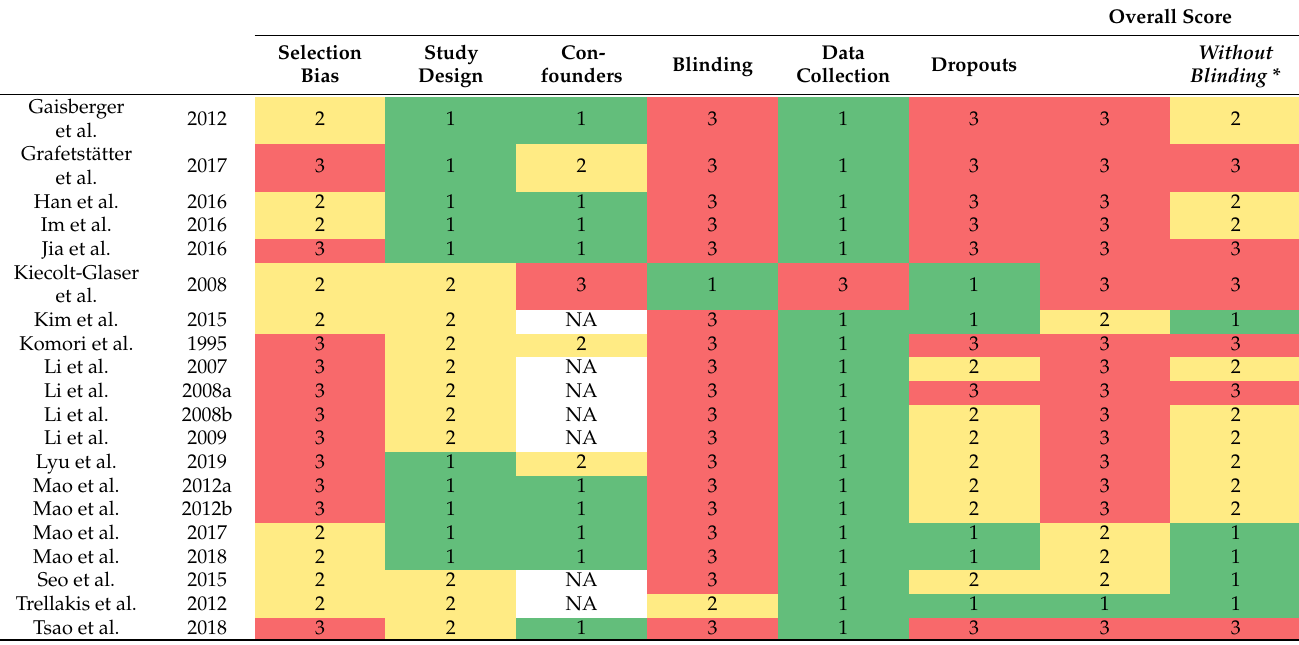
Table 3. Quality assessment of human intervention studies following the EPHPP